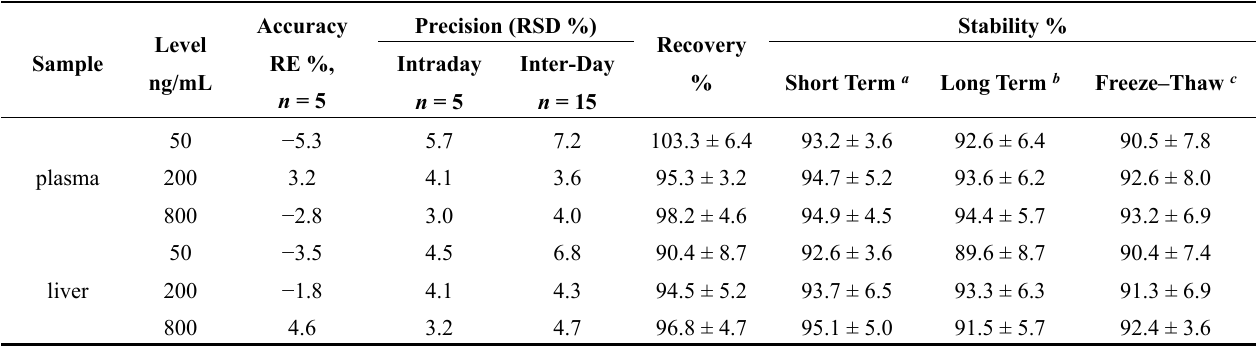
Table 1. Accuracy, precision, recovery, and stability of ellagic acid in rat plasma and liver